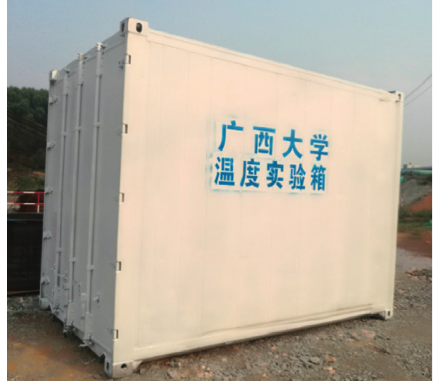
Figure 3: Temperature test box.